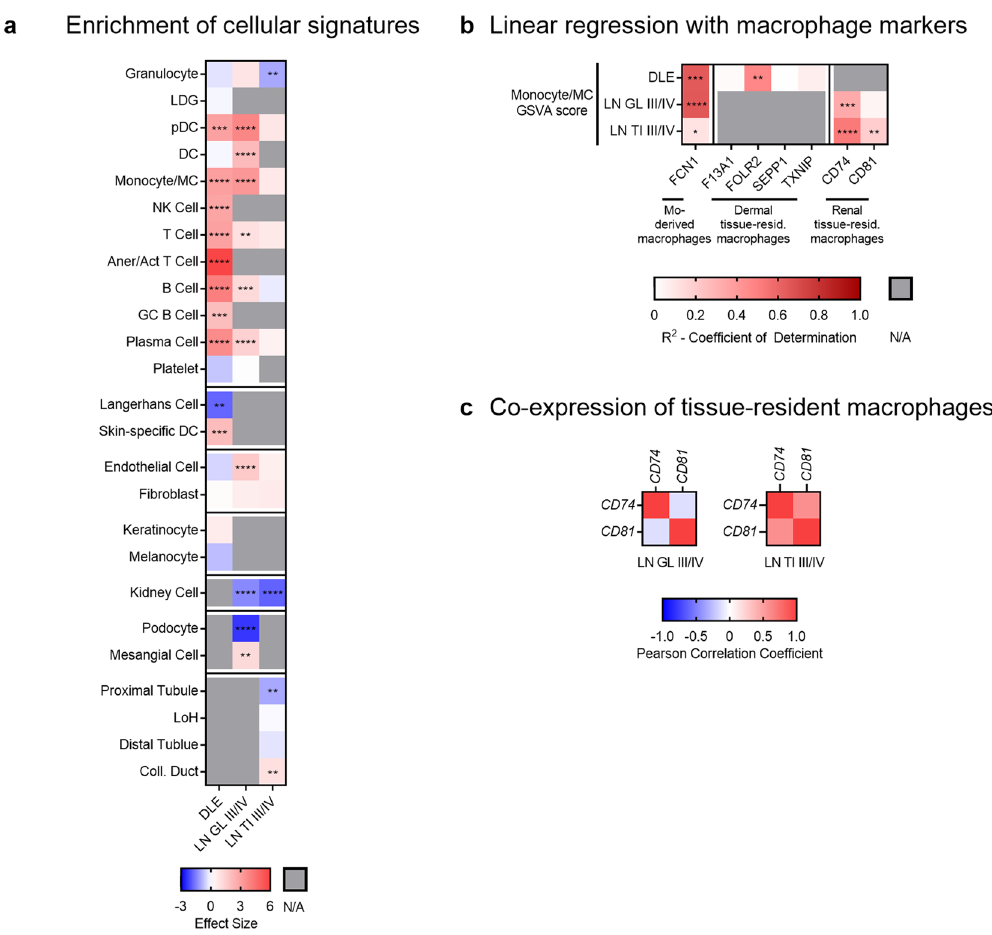
Figure 2. Increased myeloid cell signatures and decreased non-hematopoietic cell signatures characterize the majority of lupus patients . ( a ) Hedges’ g effect sizes of immune and non-hematopoietic cell signatures in DLE, class III/IV LN GL, and class III/IV LN TI as compared to tissue CTLs. Significant p-values reflect significant differences in enrichment of the immune cell signatures or non-hematopoietic cell signatures in lupus tissues as compared to CTL as determined by Welch’s t-test with Bonferroni correction (Supplemental Fig. S1). ( b ) R 2 values derived from linear regression of the monocyte-derived macrophage or the tissue-resident macrophage markers with the monocyte/MC GSVA scores in individual patients and CTLs from lupus-affected tissues (Supplemental Fig. S3). Significant p-values reflect significantly non-zero slopes. ( c ) Pearson correlation coefficients between tissue-resident macrophage markers in LN. For all calculations, the following sample numbers were used: DLE [CTL (n = 8), DLE (n = 9)], LN GL [CTL (n = 14), Cl 3/4 (n = 22)], and LN TI [CTL (n = 15), Cl 3/4 (n = 22)]. *, p < 0.05; **, p < 0.01; ***, p < 0.001; ****, p <